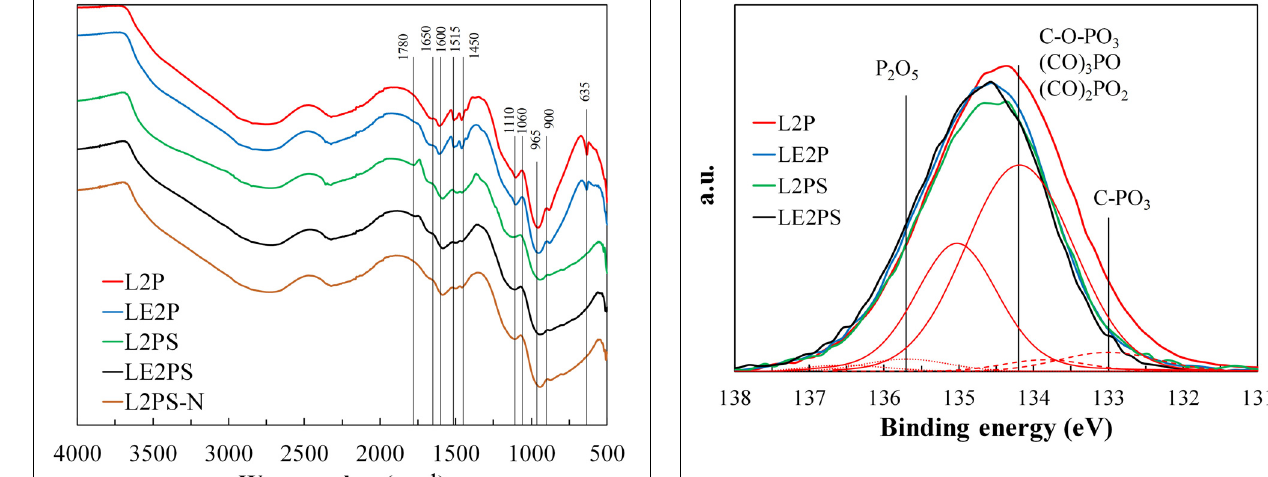
FIGURE 3 | XPS P2p spectra of the different H 3 PO 4 -lignin derived samples and deconvolution of LE2PS sample (C-O-P groups: continuous line, P 2 O 5 : dotted line and C-PO 3 : dashed